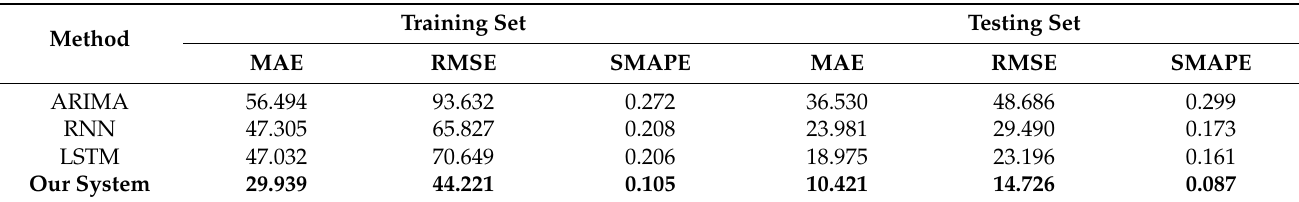
Table 8. Comparison of index values of each model on Point Petre dataset.